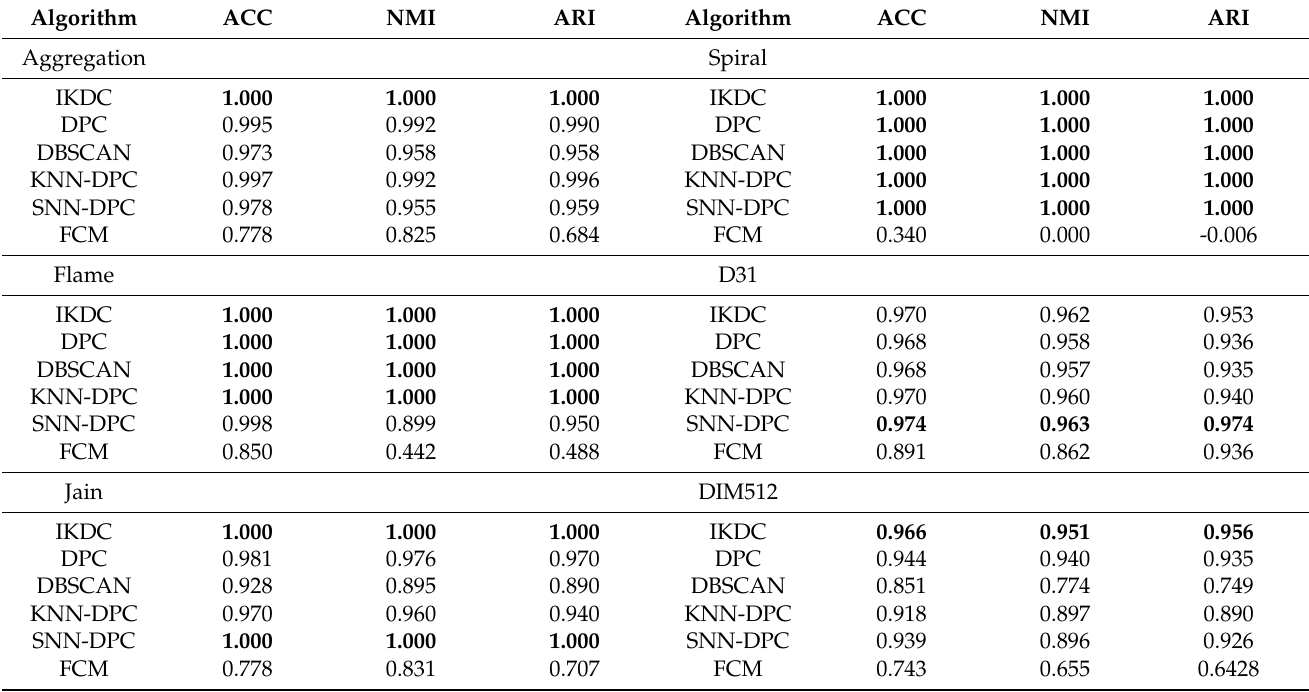
Table 4. ACC, NMI, and ARI of six algorithms on different synthetic datasets.